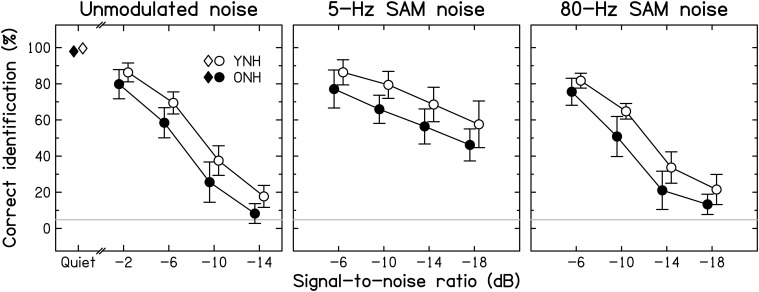
Average consonant-identification performance in different listening conditions for YNH (open symbols) and ONH (filled symbols) participants. Identification scores are given for the quiet condition (diamonds) and as a function of the signal-to-noise ratio (SNR) for the unmodulated, 5-Hz SAM, and 80-Hz SAM noise conditions (left, middle, and right panels, respectively). Here, and in the following figures, data points for the two groups are slightly displaced horizontally to aid visibility. Chance-level performance is indicated by the gray horizontal lines. Error bars represent ±1 SD.